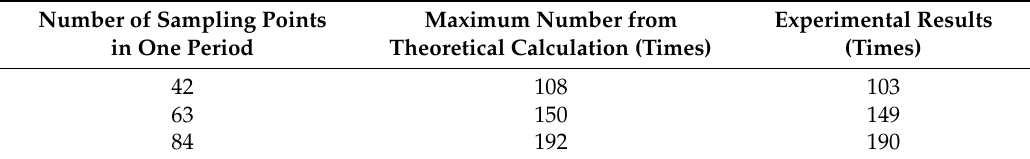
Table 5. Number of commutations of switches for 5-level inverter.